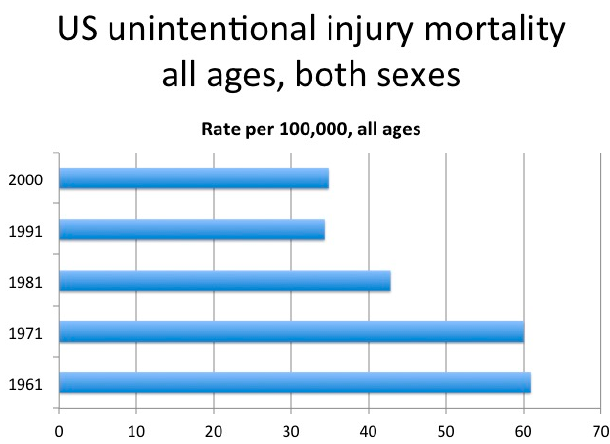
Figure 2. Death rates (per 100,000) unintentional injuries, US, 1961–2000, all ages, both sexes.